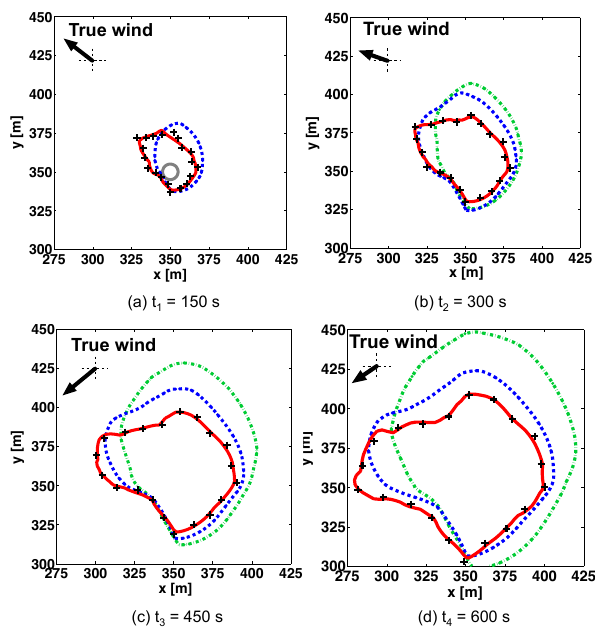
Figure 11. OSSE anisotropic case over multiple assimilation cycles (from 0 to 600s): comparison between the free run (green dashed- dotted line), the mean forecast estimate (blue dashed line), observa- tions (black crosses) and the mean analysis estimate (red solid line) at 150s time intervals, at times (a) t 1 = 150s (the gray circle cor- responds to the true initial location); (b) t 2 = 300s; (c) t 3 = 450s; and (d) t 4 =